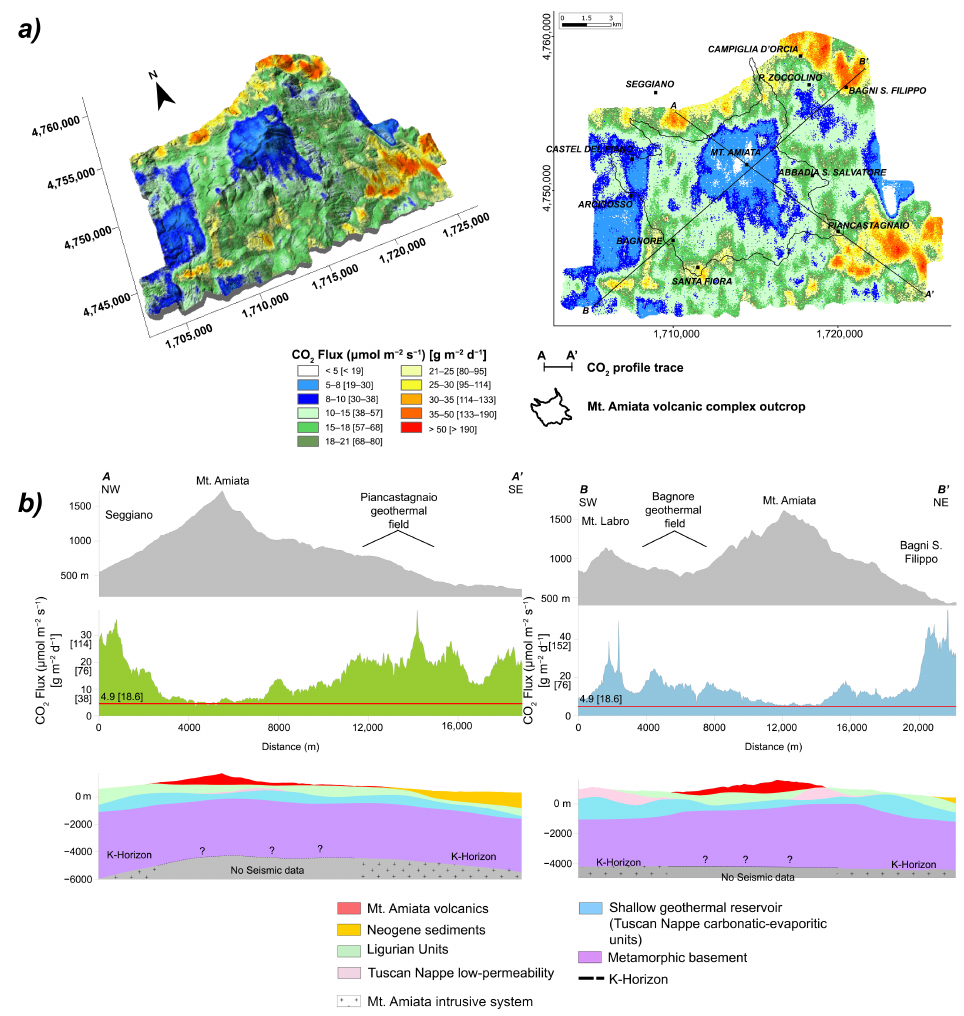
Figure 7. ( a ) sGs map of soil CO 2 flux AVGA superimposed on a 3D DTM (Digital Terrain Model) of AVGA; ( b ) Soil CO 2 flux profiles in relation to topographic profiles and geological sections reporting the main geological formations and the K-horizon, proxy of the granite